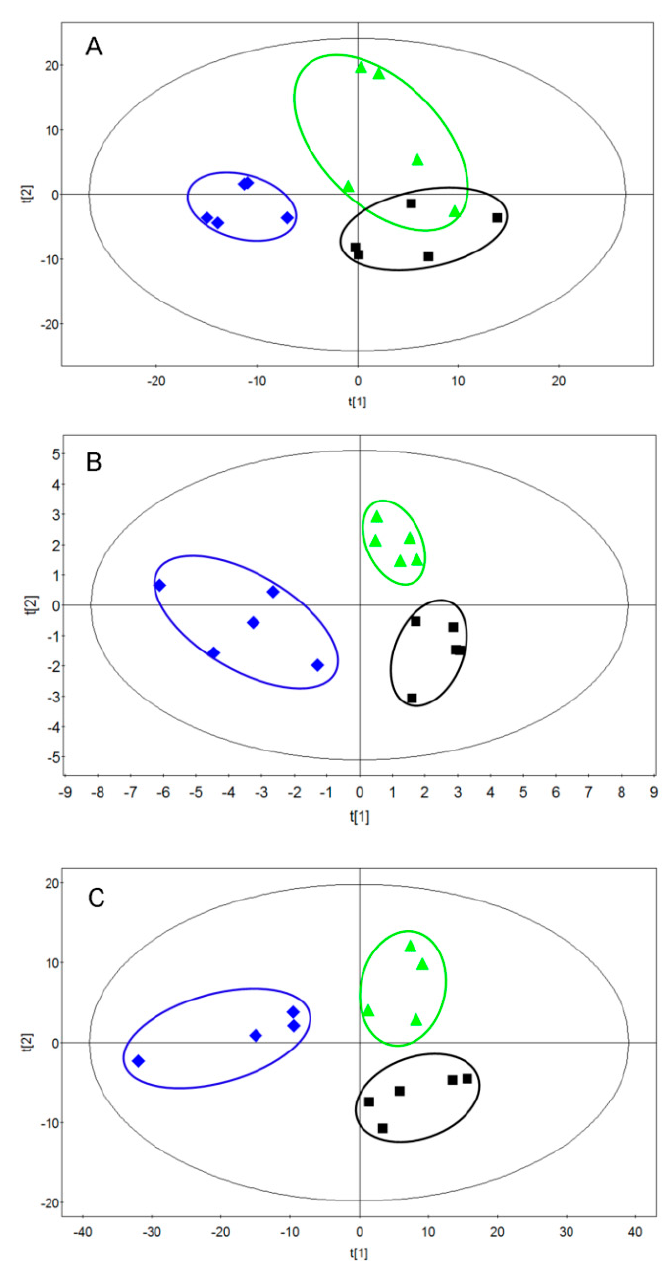
Figure 3. Partial least-squares discriminant analysis (PLS-DA) based on urine 1 H-NMR spectra. ( A ) 10 mg/kg treatment (R2X = 0.729, R2Y = 0.762, Q2 = 0.823); ( B ) 30 mg/kg treatment (R2X = 0.773, R2Y = 0.846, Q2 = 0.917); ( C ) 60 mg/kg treatment (R2X = 0.807, R2Y = 0.854, Q2 = 0.891); ( ■ ) control group, ( ◆ ) metalaxyl-M treated group, ( ▲ ) rac- metalaxyl treated group.